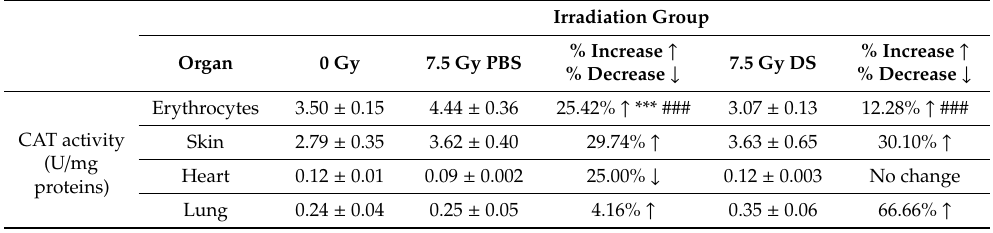
Table 3. CAT activity in erythrocytes, lung, heart and skin of mice irradiated by PBS or DS proton beams in the plateau phase of the Bragg peak.